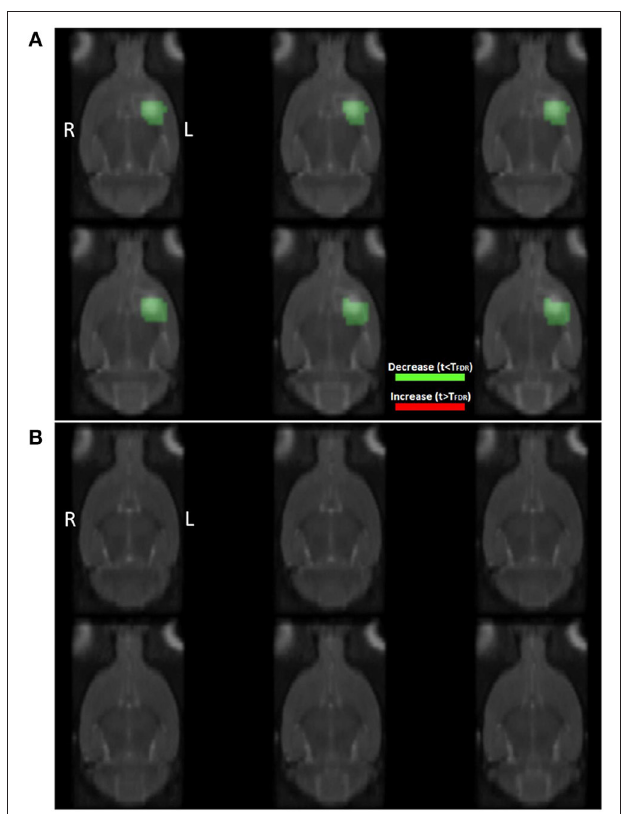
FIGURE 4 | Coronal slices showing the results of statistical analysis on the group level using t -test statistics with correction for multiple comparisons when comparing (A) [18F]-FDG PET images of ICH animals ( n = 9), and (B) [18F]-FDG PET images of control animals ( n = 9), to the normal [18F]-FDG PET rat brain atlas ( n = 28). T FDR : threshold calculated in SPM using False Discovery Rate based correction for multiple comparisons ( p < 0.05). Red: significantly increased glucose uptake (not visible in this image), green: significantly decreased glucose uptake. Colored regions are overlayed on the interpolated T2 templates of ICH and control animals at day 1 post-injection, respectively.